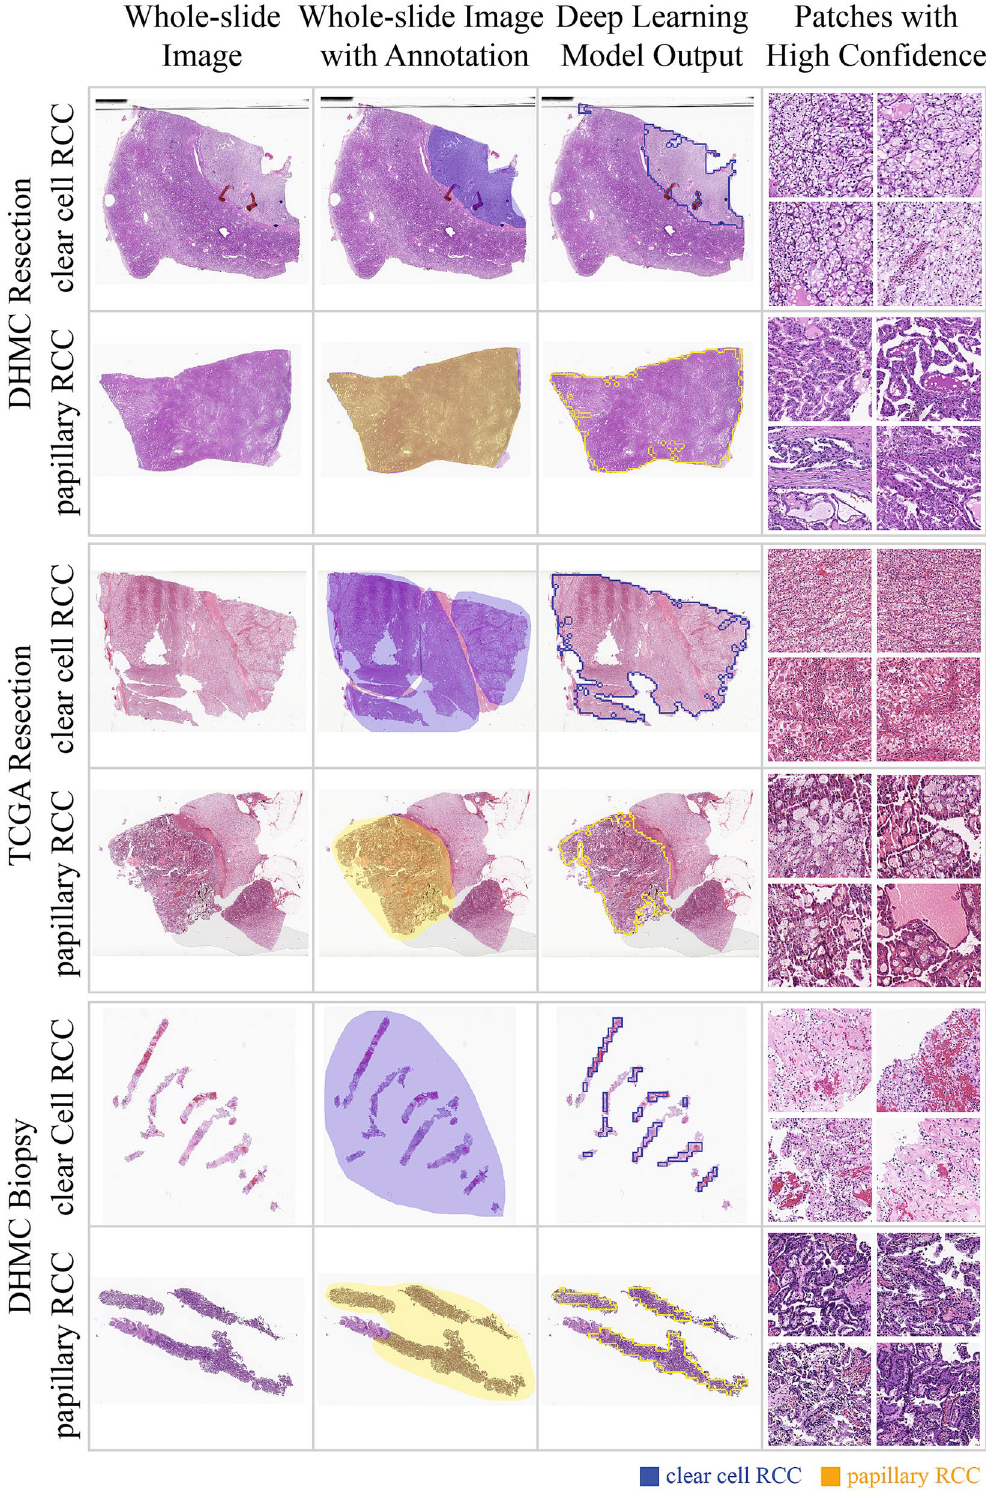
Figure 3. Examples of visualized slides from our test sets with highlighted regions of interest for predicted classes using our model. Clear cell RCC and papillary RCC classes are common among the three test sets and thus are used for this illustration. Top row: A surgical resection whole-slide image in the DHMC test set. Middle row: A surgical resection whole-slide image from the TCGA test set. Bottom row: A biopsy whole-slide image from